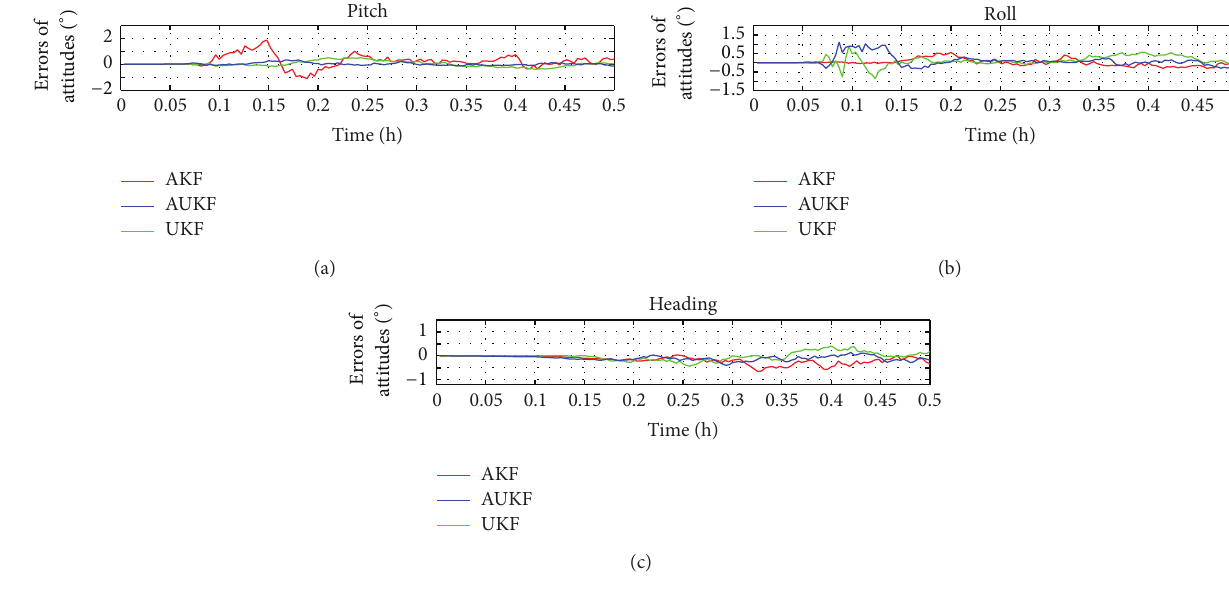
Figure 5: Comparison of attitude errors.